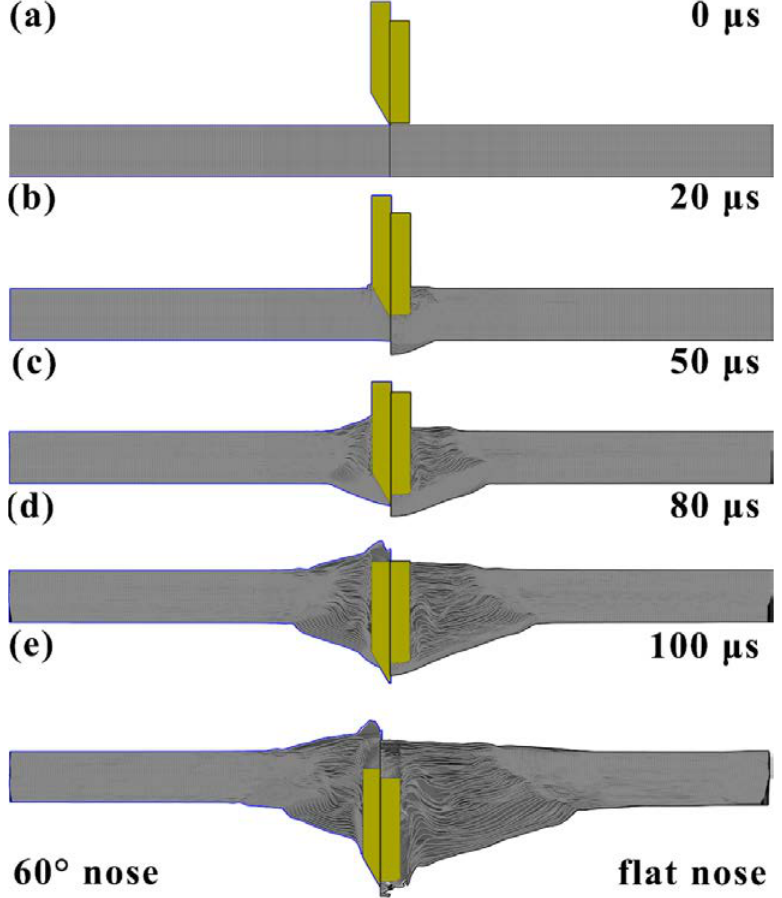
Figure 7. The damage evolution of the laminate impacted with 60° and flat nose projectile: ( a ) for the 60° conical and flat nose projectiles penetration; ( b ) the projectile nose penetrated into the com- posite; ( c ) the bulge deformation and delamination of the fibers; ( d ) the tensile deformation of the composite; ( e ) the damage morphology after the penetration.